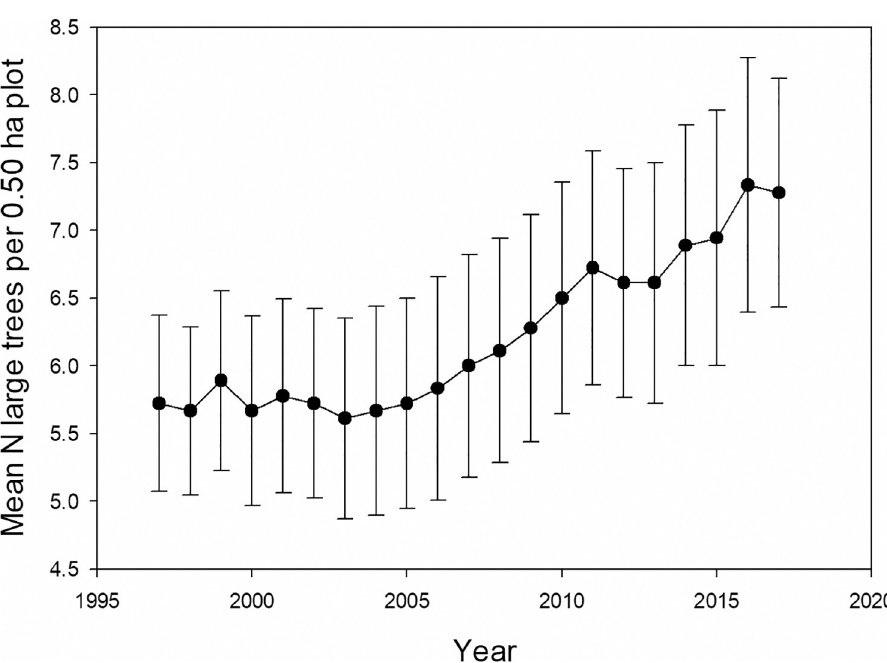
Fig 3. Large tree density. The mean number of large trees per plot in 18 0.50 ha long-term inventory plots from 1997– 2017, ± 1 SEM.